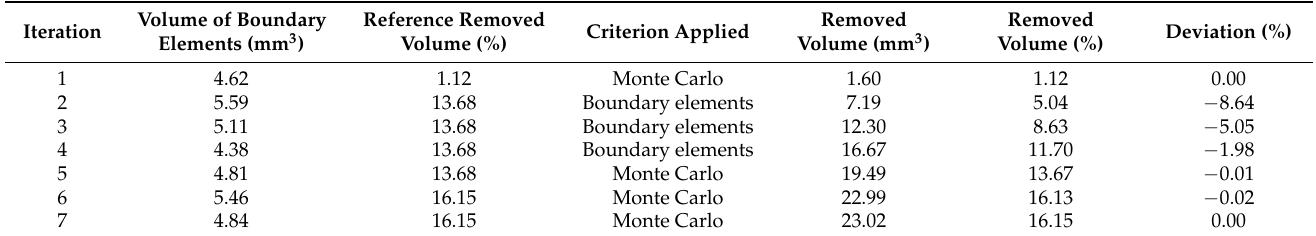
Table 4. Degradation results of the numerical method (PCL:MCC 98:2